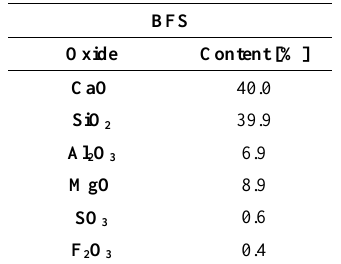
Table 2. Percentage of oxides in